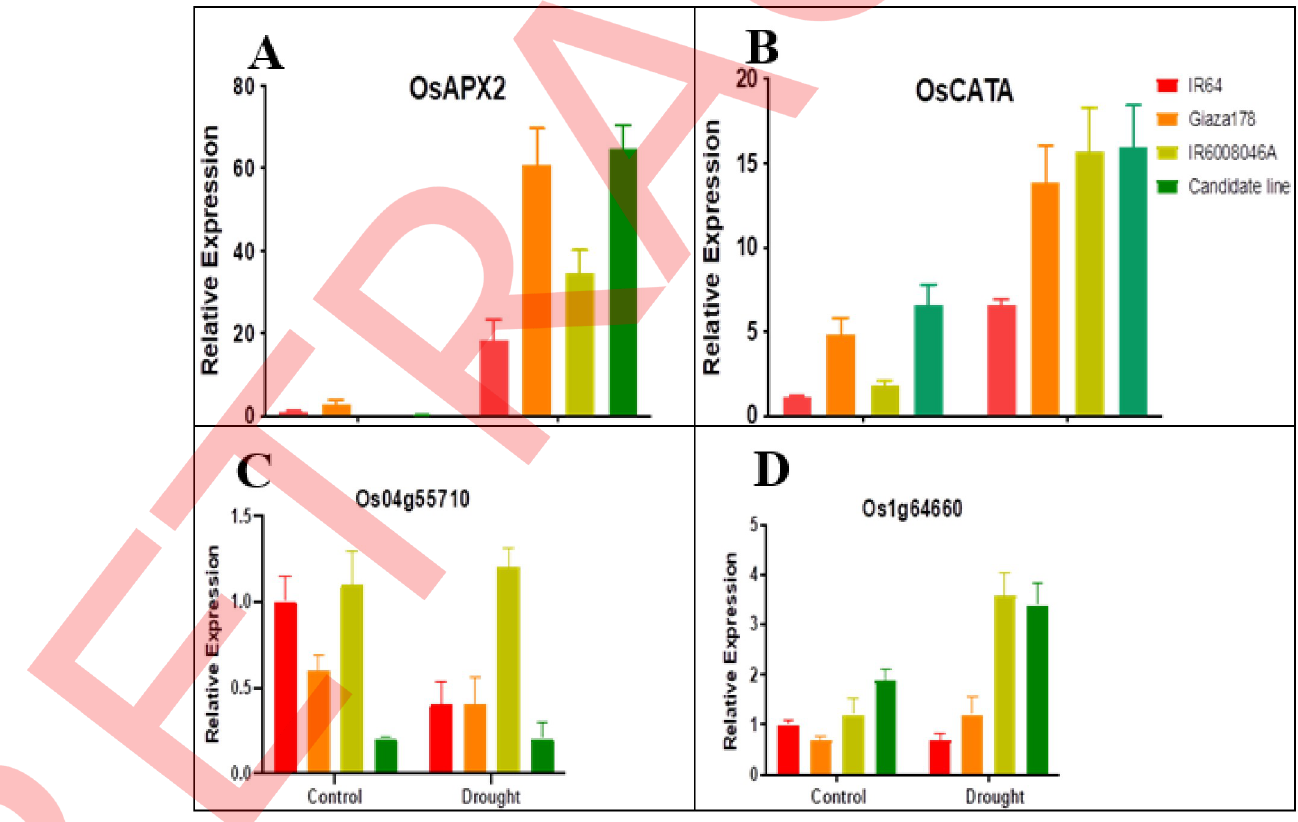
Fig 5. The expression level of OsAPX2 (A), OsCATA (B), Os0g557710 and Os1g64660 (D); under normal and drought-stress conditions. Data are represent as means ± SEM, (n = 6).